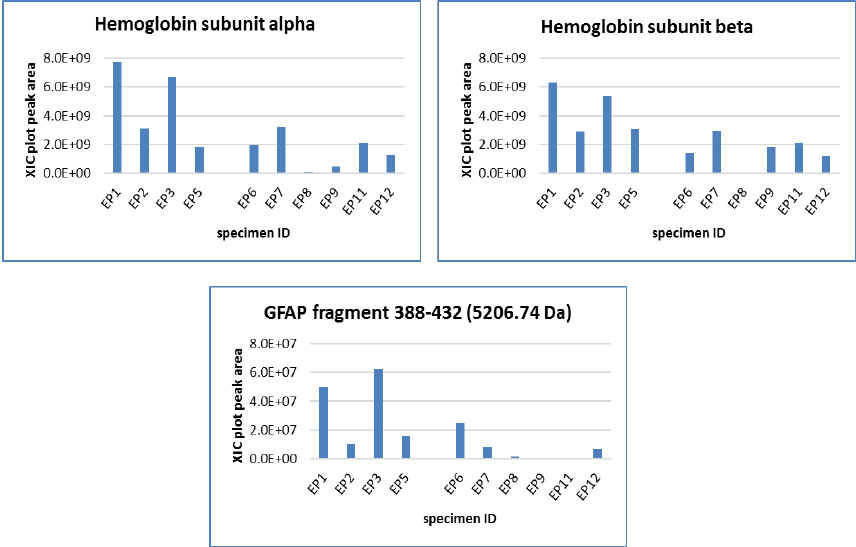
Figure 4. Proteins with statistically significant variation between WHO grade II (EP1–3, EP5) and grade III (EP6–9, EP11, EP12) PF ependymomas.